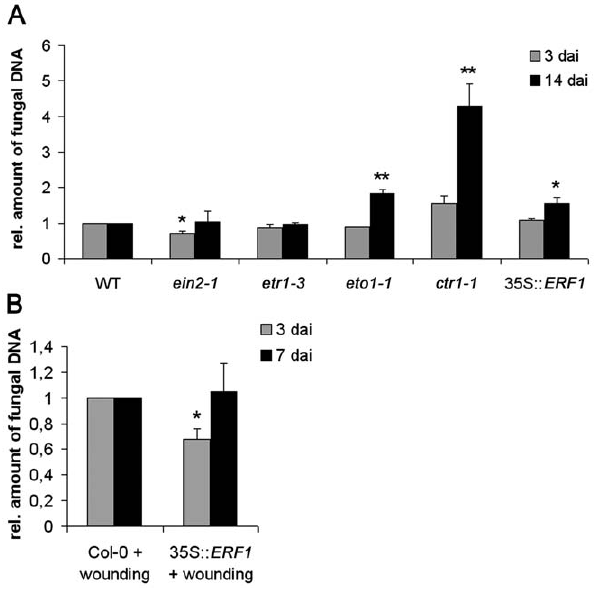
Figure 6. Colonization of ethylene synthesis and signaling mutants by P.indica . ( A ) Three-week-old plants were inoculated with P. indica and fungal biomass was determined in ein2-1 , etr1-3, eto1-1, ctr1-1 , and 35S :: ERF1 by qRT-PCR at 3 and 14 dai. ( B ) Three-week-old 35S::ERF1 plants were injured with foreceps and inoculated with P. indica at 1 day after wounding. Fungal biomass was determined by qRT- PCR at 3 and 7 dai. All values were related to Col-0 (set to one). The data are based on at least three independent experiments. Students t -test indicated significant difference in P. indica -colonization (* P , 0.05, ** P , 0.001).